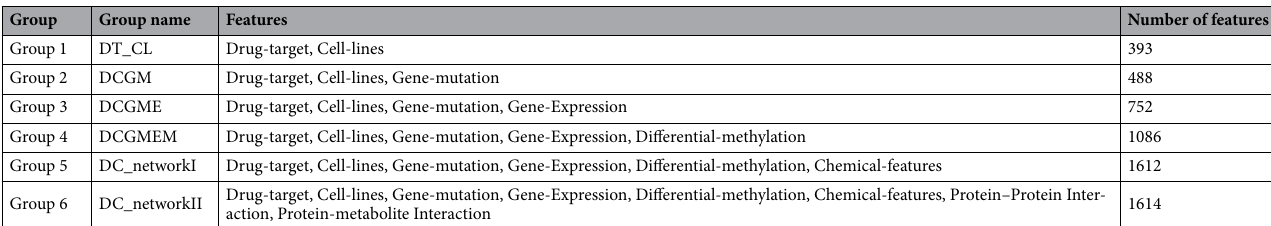
Table 3. Feature group description. The name of each group has been determined based on their feature groups. DT_CL drug targets and cell lines, DCGM drug targets, cell lines, and gene mutation, DCGME drug targets, cell lines, gene mutation, and gene expression, DCGMEM drug targets, cell lines, gene mutation, gene expression, and differential methylation, DC_networkI drug targets, cell lines, gene mutation, gene expression, differential methylation, and chemical features, DC_networkII drug targets, cell lines, gene mutation, gene expression, differential methylation, chemical features, protein–protein interaction, protein metabolite